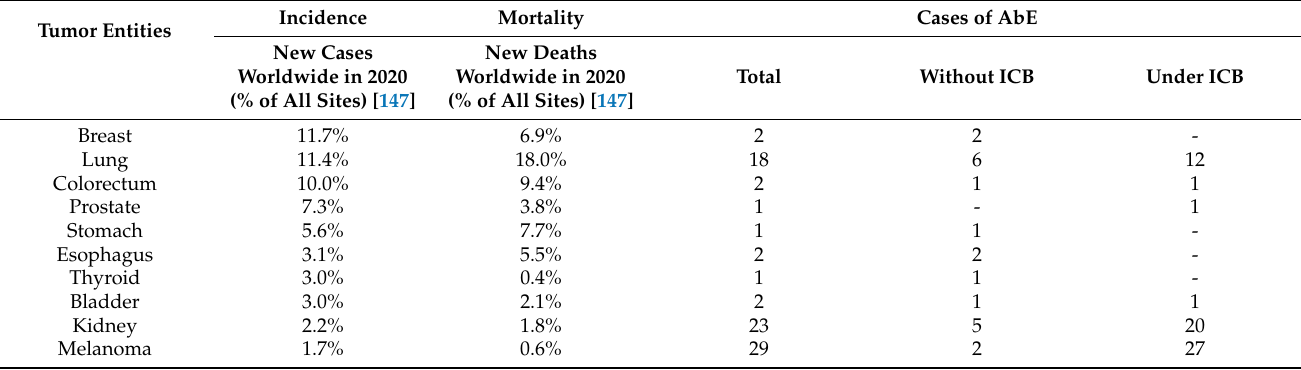
Table 3. Abscopal effect case reports in different tumor